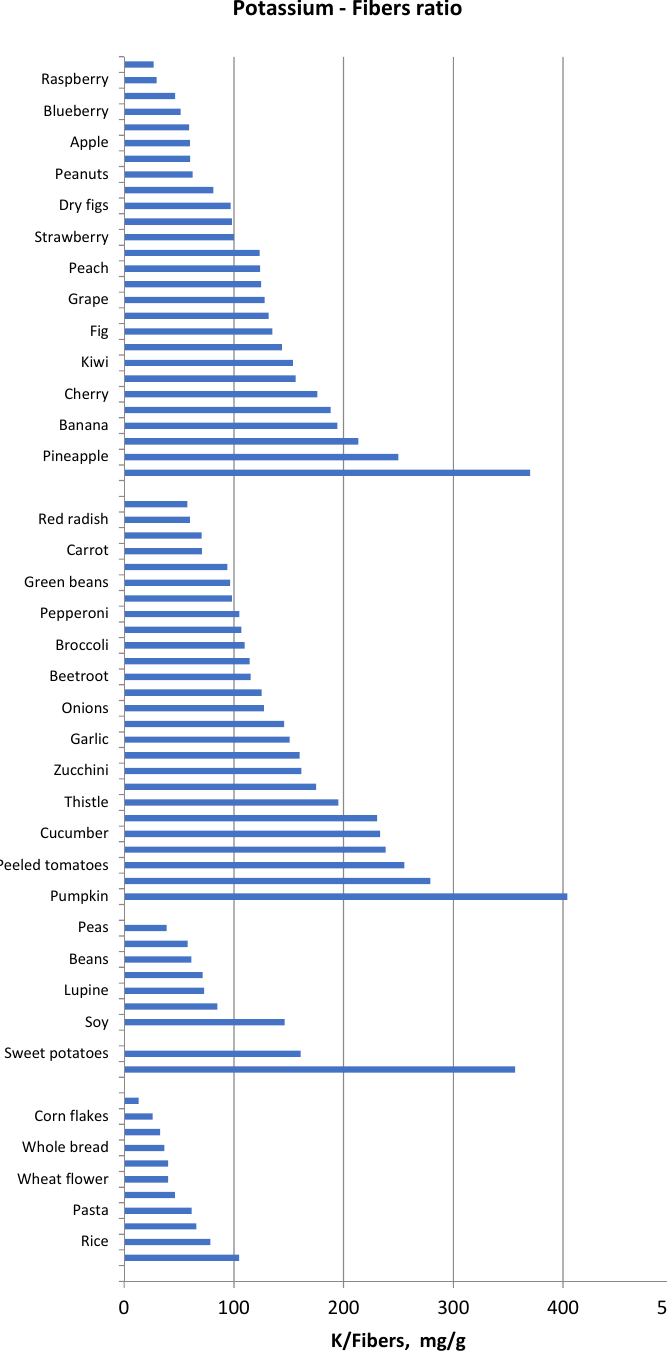
Figure 1. Potassium to fibre ratio (mg/g) in several food